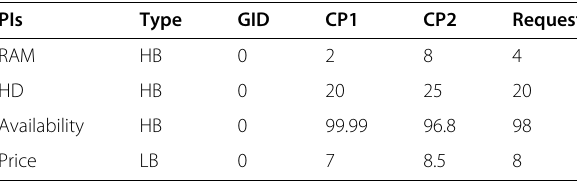
Table 4 CP PI database and user request